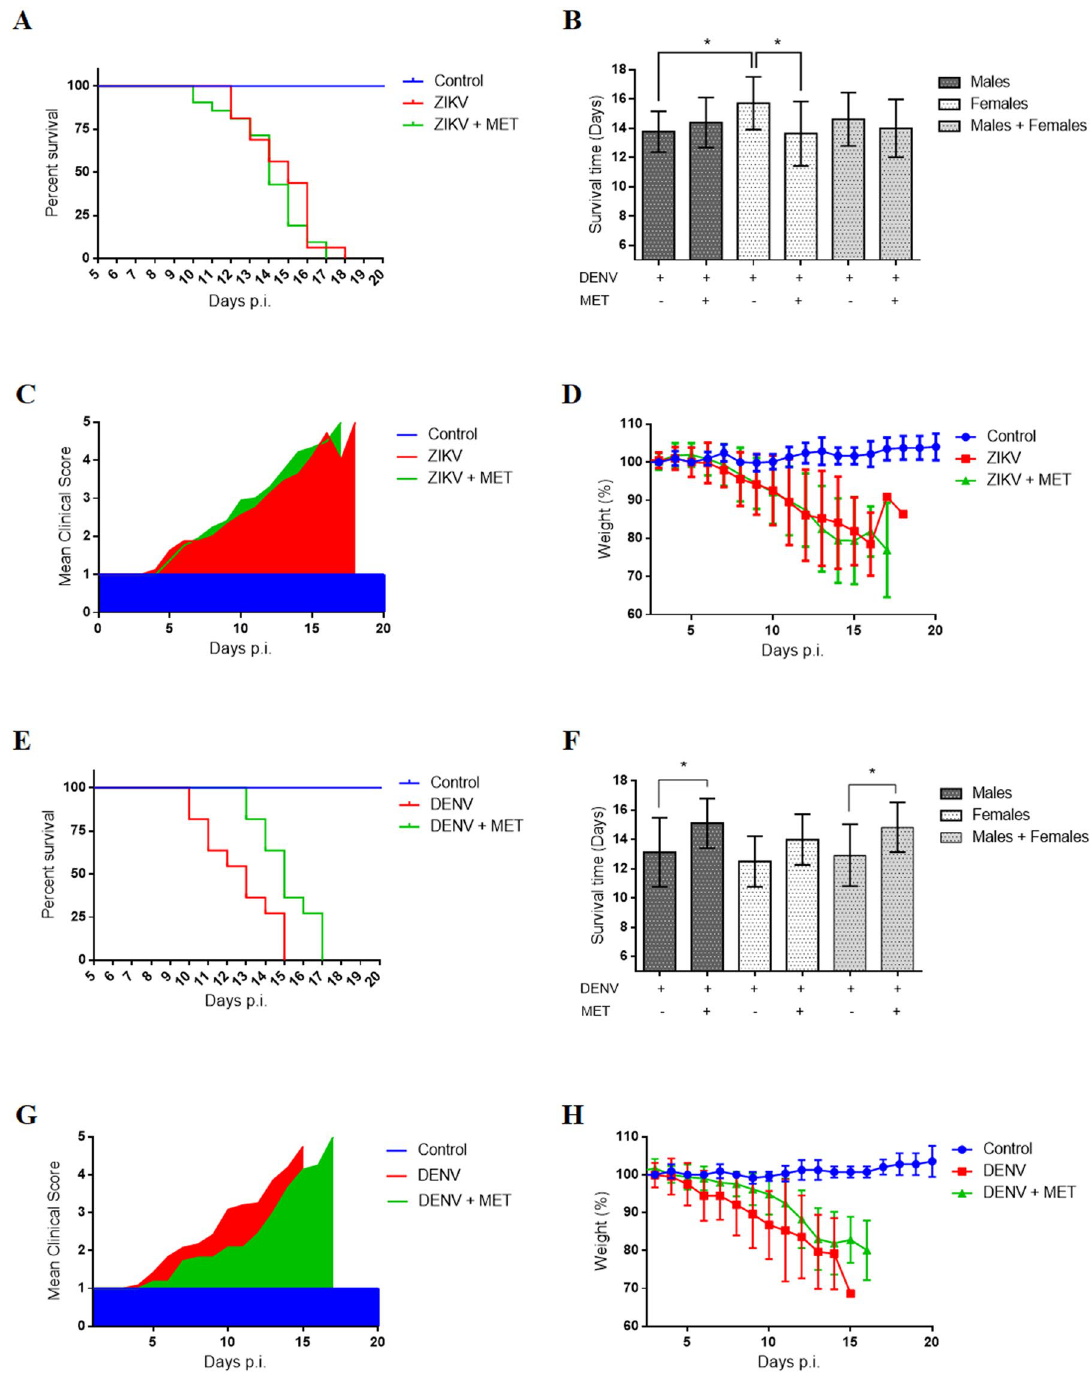
Figure 6. Effect of MET treatment on the survival of ZIKV- and DENV-infected AG129 mice. The “Control” group consisted of mice that were treated with MET and were not infected; the “ZIKV or DENV” group consisted of mice that were infected with each virus and untreated (H2O); the “ZIKV or DENV + MET” group consisted of mice that were inoculated with DENV or ZIKV and were treated with MET. ( A ) Kaplan–Meier curve, ( B ) average survival rate, ( C ) Mean clinical score, ( D ) and average body weight percentage of ZIKV-infected AG129 mice. ( E ) Kaplan–Meier curve, ( F ) average survival rate, ( G ) Mean clinical score, ( H ) and average body weight percentage of DENV-infected AG129 mice. The graphs represent groups of mice of both sexes, except graphs ( B , F ), which show the average survival rates of male, female, and both sexes, with and without MET treatment. Days post-infection (Days p.i.). * indicate statistically significant differences between the MET treated and untreated groups; the summary of survival trials is shown in Table